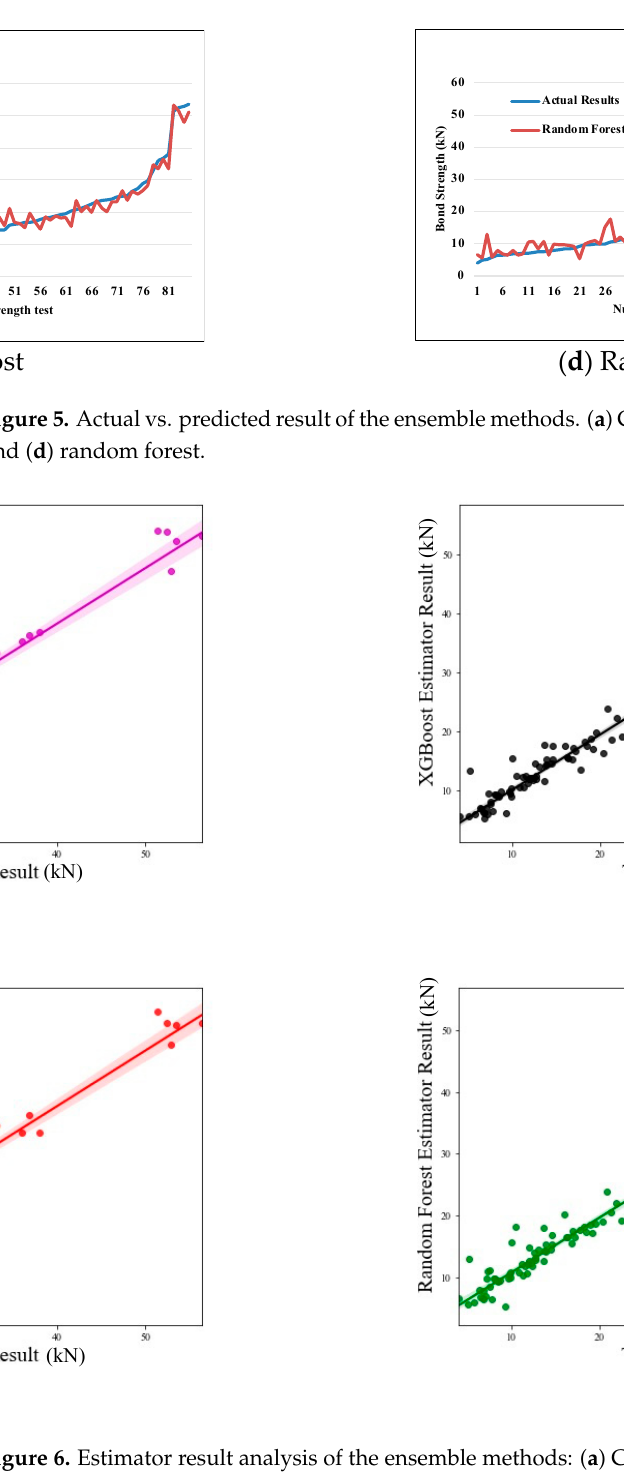
Figure 6. Estimator result analysis of the ensemble methods: ( a ) CatBoost, ( b ) XGBoost, ( c ) HGBoost, and ( d ) random forest.